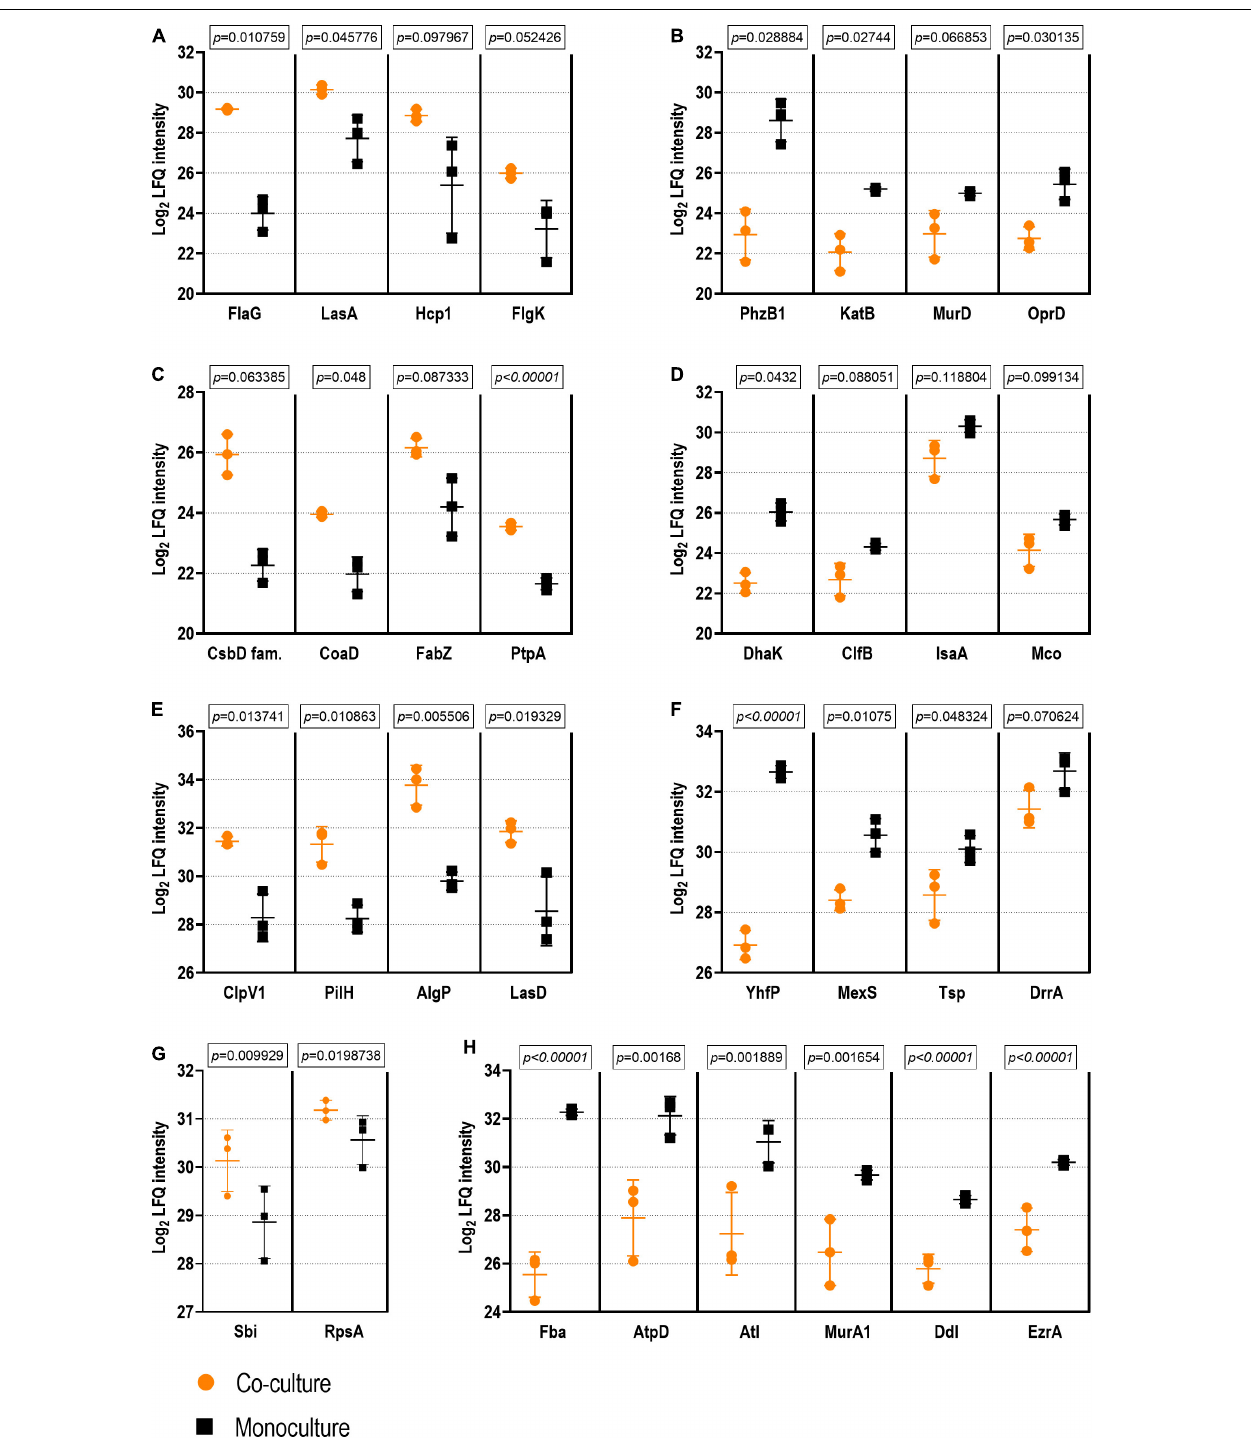
FIGURE 5 | Examples of proteins with statistical differences of abundance in co-culture vs . monoculture. The exoproteome is represented by examples of Pseudomonas aeruginosa proteins with higher (A) and lower abundance (B) as well as by examples of Staphylococcus aureus proteins with higher (C) and lower abundance (D) in co-culture vs . monoculture. The surfaceome is represented by examples of P. aeruginosa proteins with higher (E) and lower abundance (F) as well as by examples of S. aureus proteins with higher (G) and lower abundance (H) in co-culture vs . in monoculture. Student’s t -test q -Values (permutation-based false discovery rate) are presented for each comparison (see Supplementary Tables 6–9 for the complete dataset).